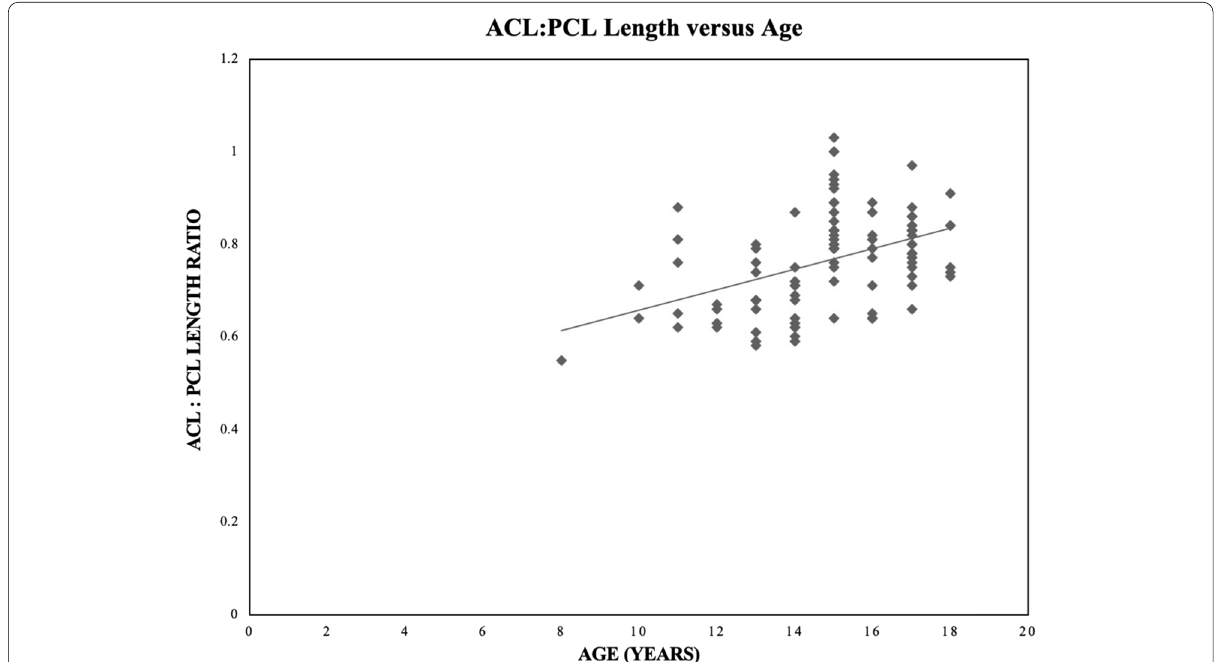
Fig. 7 Scatter plot with best-fit line of ACL:PCL length ratio versus age in years. A positive correlation exists between ACL:PCL length ratio and age ( p < 0.0001, R =